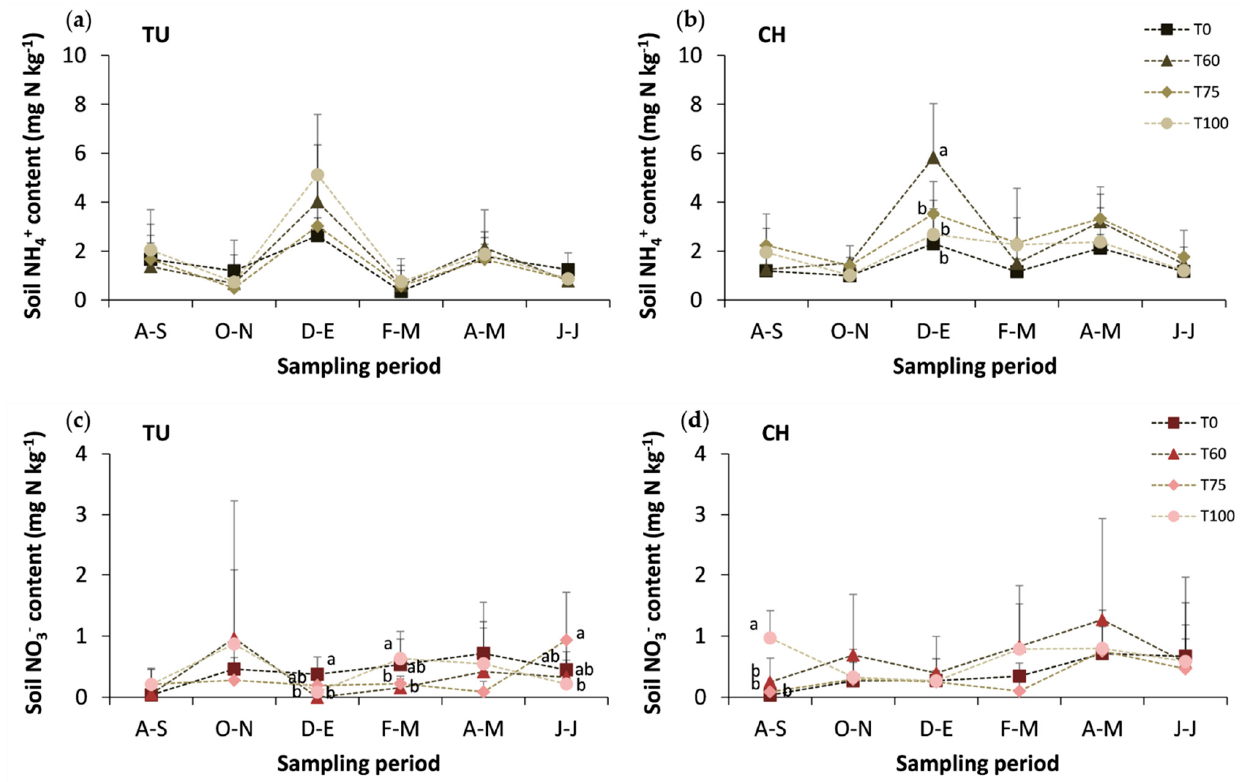
Figure 2. Temporal evolution of initial content in soil of ( a ) ammonium in Tuéjar, ( b ) ammonium in Chelva, ( c ) nitrate in Tuéjar and ( d ) nitrate in Chelva as a function of silvicultural treatments.